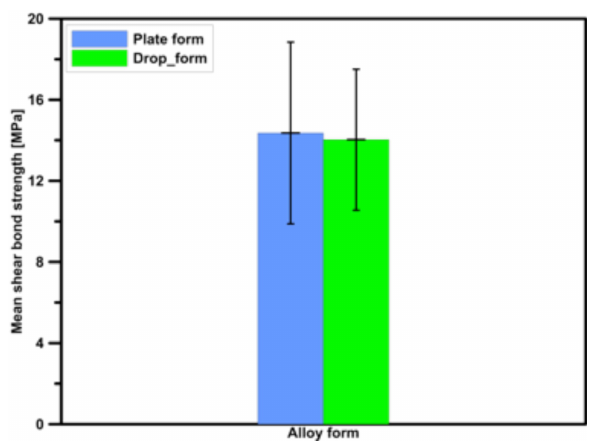
Figure 7: Mean values of SBS with corresponding standard devia- tions